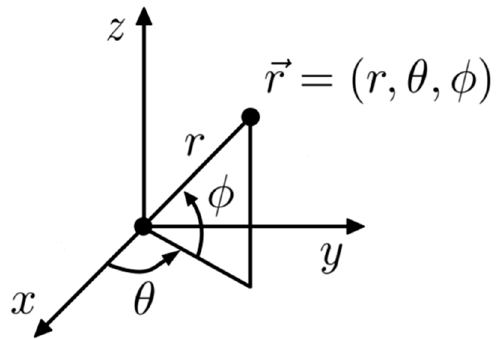
Figure 16. Spherical coordinate system.